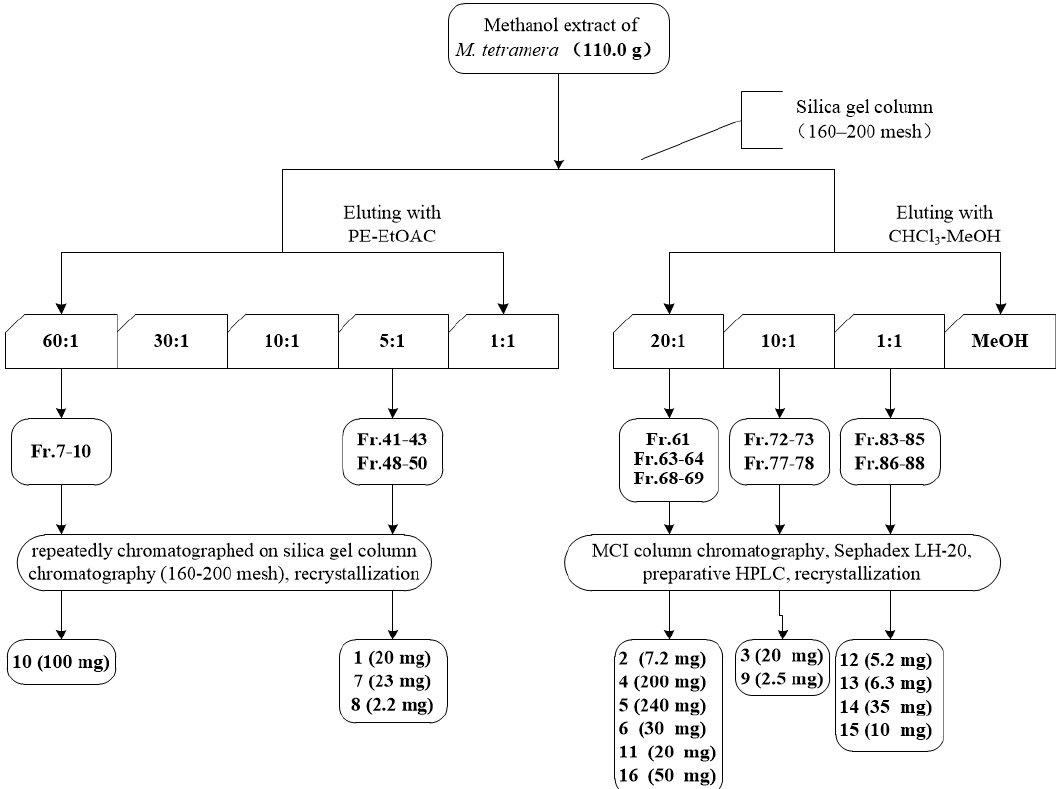
Figure 3 . The tree-type figure for separation procedure. Figure 3. The tree-type figure for separation